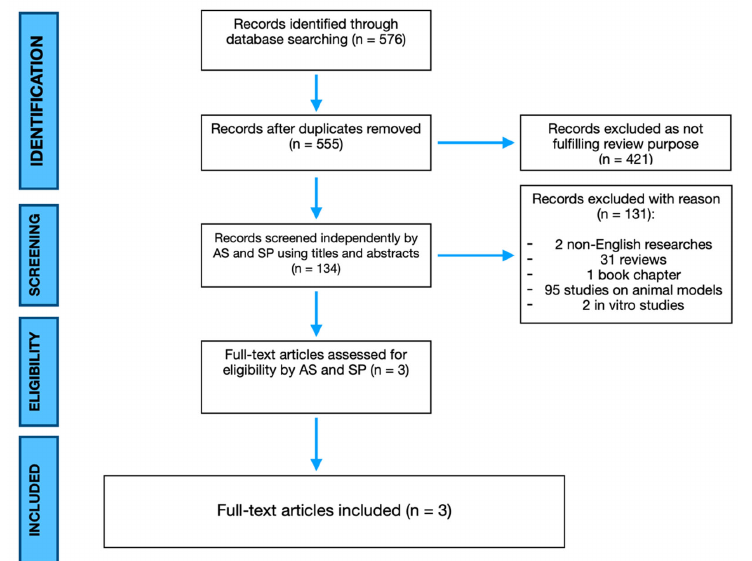
Figure 1. PRISMA flowchart highlighting search strategy and paper selection.